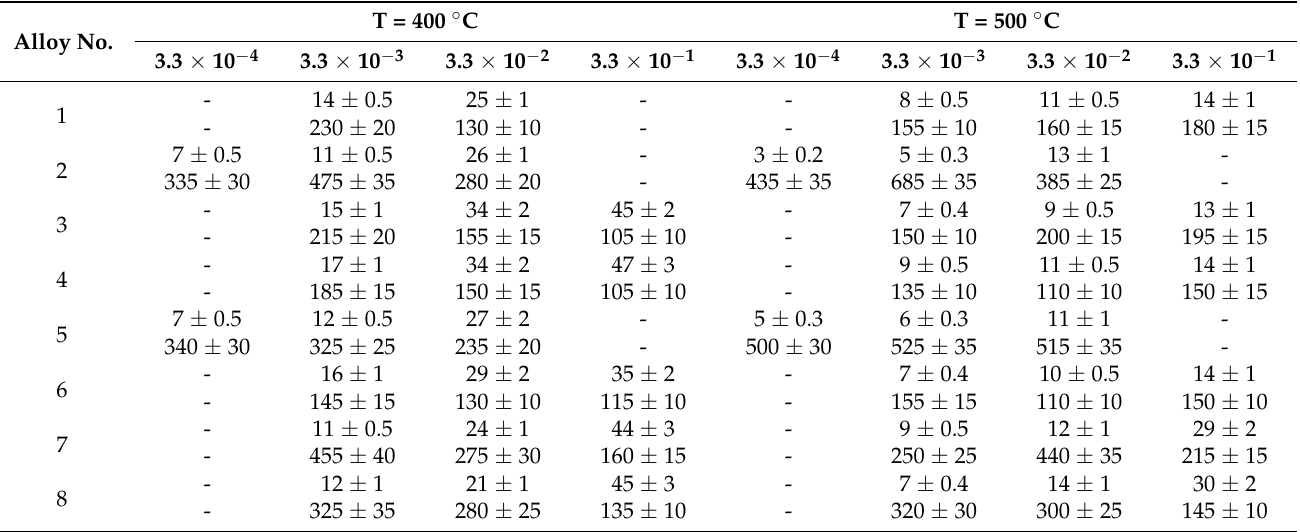
Table 4. Results of tensile tests of UFG alloy specimens at elevated temperatures and strain